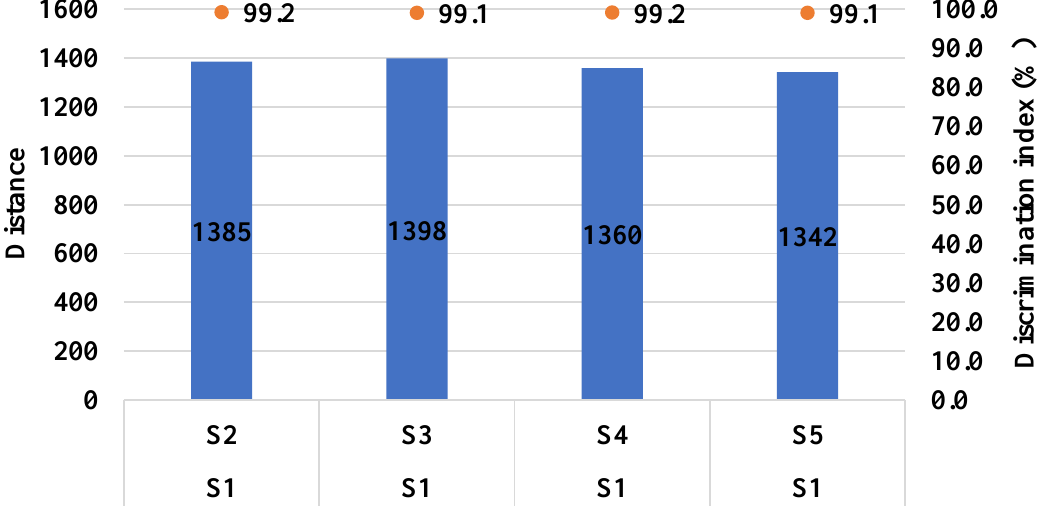
Figure 5. Pairs comparison of samples [S1–S2], [S1–S3], [S1–S4], [S1–S5]. S1: Xylocaine ® , S2: Xylocaine ® + 0.338% CTE + 0.09% sodium saccharine, S3: Xylocaine ® + 0.184% CTE + 0.09% sodium saccharine, S4: Xylocaine ® + 0.414% RAS + 0.09% sodium saccharine, S5: Xylocaine ® + 0.237% RAS + 0.09% sodium saccharine.